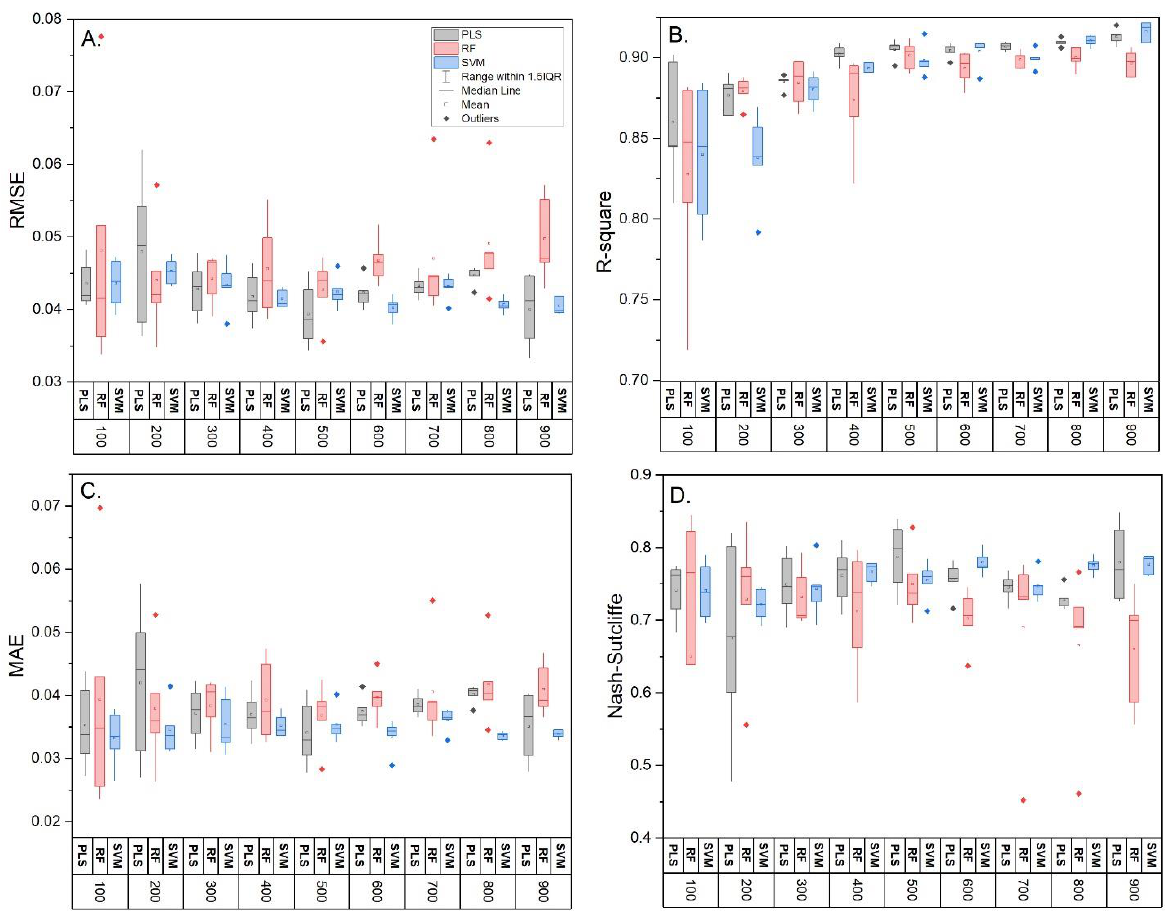
Figure 4. Box-plots graph showing the ability performance of partial least squares (PLS), random forest (RF) and support vector machine (SVM) models in for predicting soil total nitrogen content using various calibration sampling size (100 – 900 samples). Each boxplot represents the results for the five random repetitions for each sample sizes. The performance metrics include ( A ) coefficient of determination root mean square error (RMSE), ( B ) coefficient of determination (R-square), ( C ) mean absolute error (MAE), and ( D ) Nash – Sutcliffe.